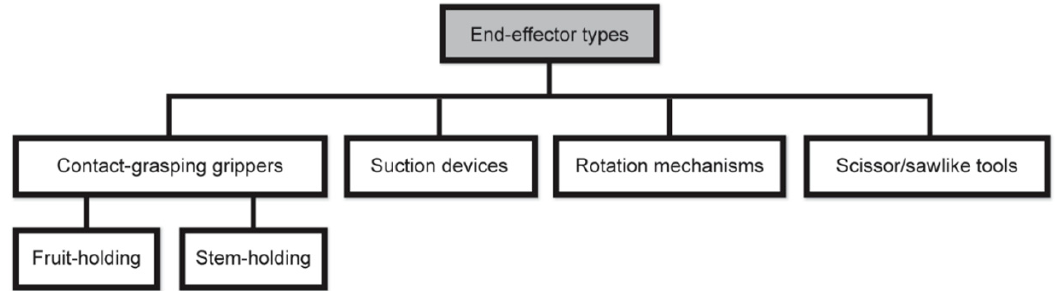
Figure 3. The four identified end-effector types considered in this work.